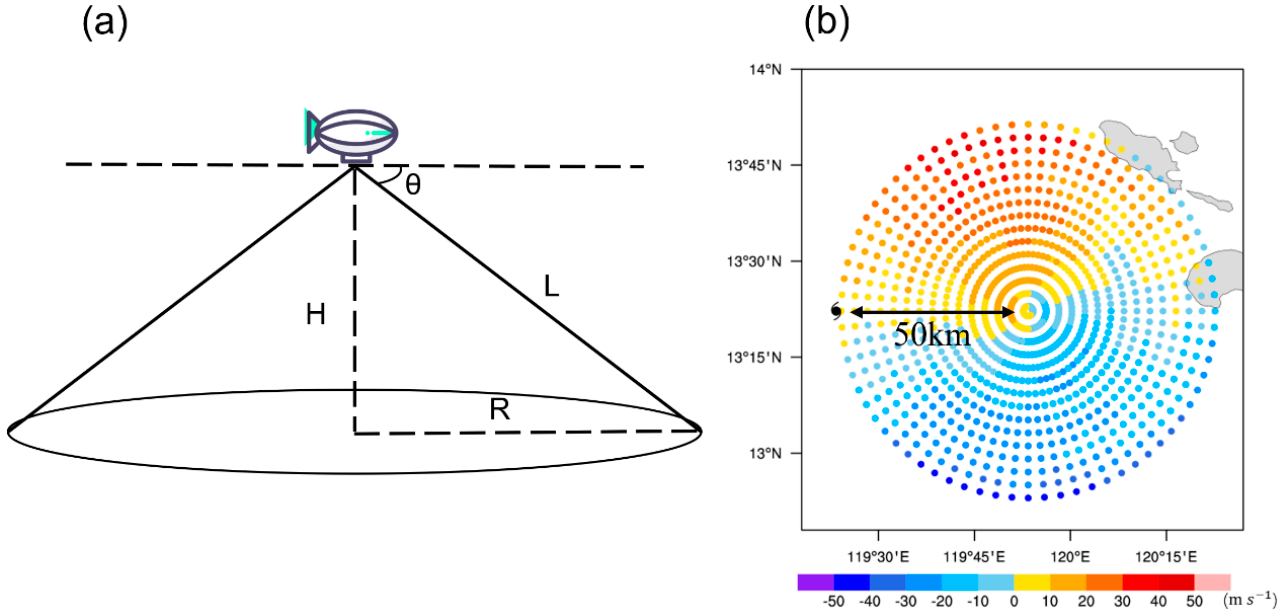
Figure 3. ( a ) Schematic diagram of airship-borne Doppler radar observation space. θ , L, H, and R denote the radar depression angle (D-ang), radar maximum detection distance, vertical detection range, and horizontal detection range, respectively. ( b ) The simulated radial winds of TC Molave in nature run when D-ang equals 30° and distance of the airship from the TC center equals 75 km.